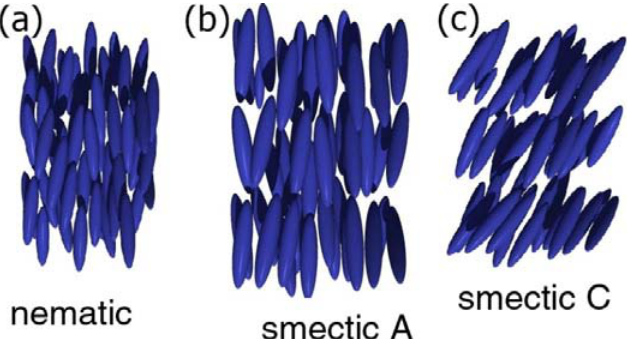
Figure 1. Schematic representation of the ( a ) nematic; ( b ) smectic A (SmA) and ( c ) smectic C (SmC) phase of calamitic (rod-like) mesogens. Molecular order increases on cooling from the left to the right side of the diagram.